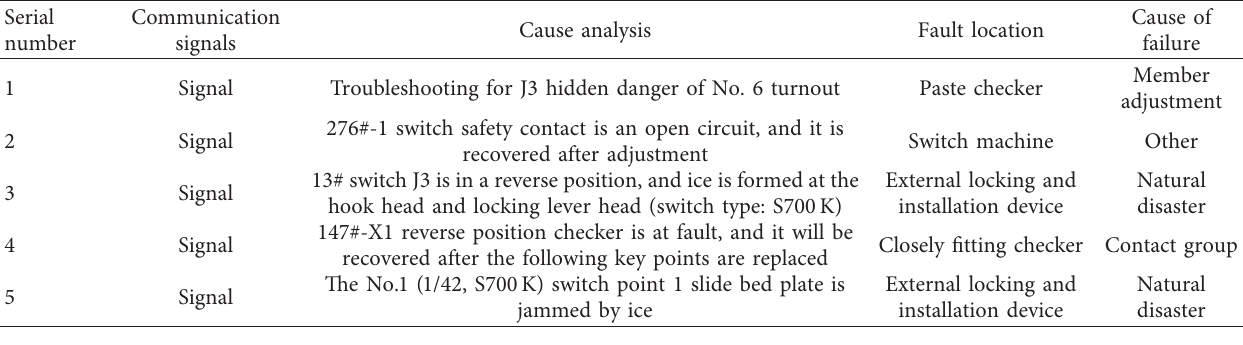
Table 1: Sample data of high-speed railway signal turnout